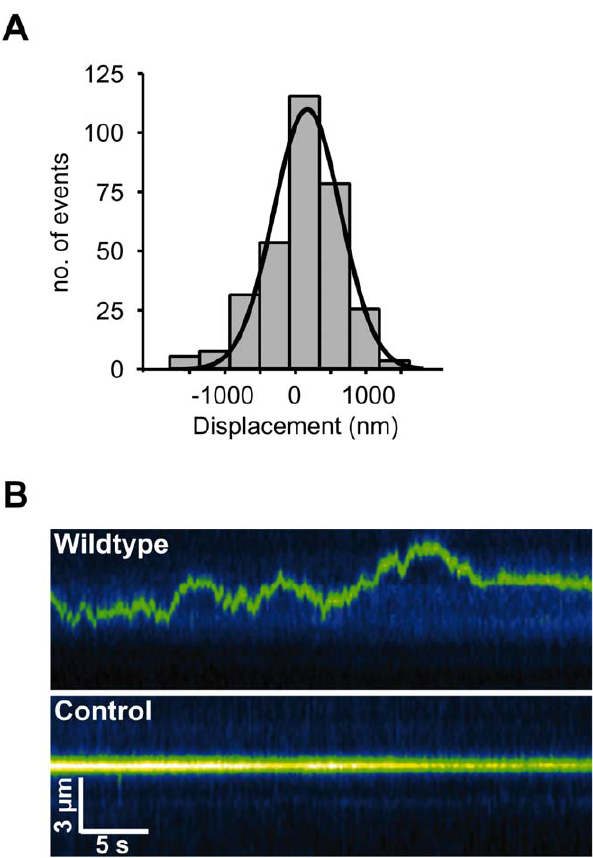
Figure 5. One-dimensional diffusive motion of myosin V on microtubules lacking the E-hook. (A) The displacement between successive image frames of diffusive movements for myo V Wildtype on S- microtubules was determined. TIRFM movie sequences of 100 nM Cy3- labeled myo V Wildtype on Atto488-labeled microtubules were analyzed and plotted as a displacement histogram. The diffusion coefficient D was calculated according to the equation, D = s /2 t , where t represents the time interval between images and s the variance. s was obtained from the Gaussian fit (solid line), resulting in D =0.226 m m 2 /s (n=327). (B) Kymograph of sequential frames depicting the diffusive motion of a single Cy3-labeled myo V Wildtype molecule (pseudo-colored green) on Atto488-labeled S-mmicrotubules (for this purpose not visualized). Control represents a stationary, non-diffusing motor molecule on the